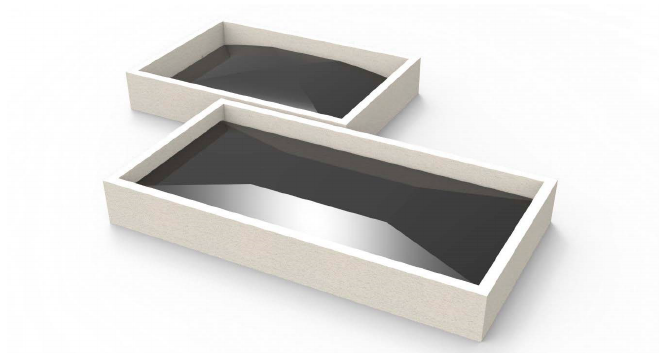
Figure 25. Multi-size application for EPS cushion packaging.